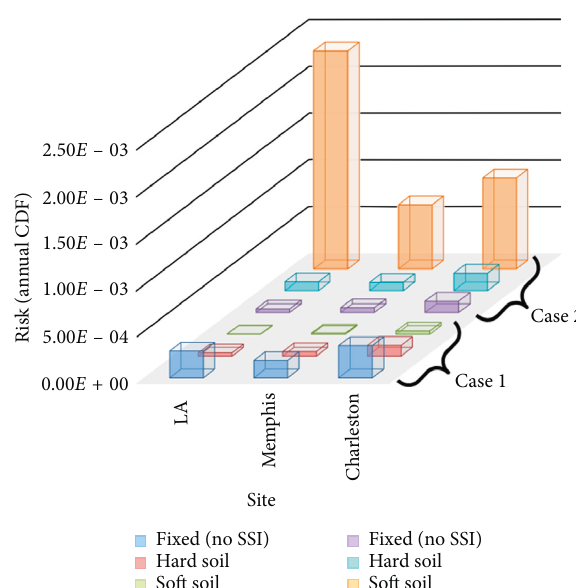
Figure 16: Comparison of the annual core damage